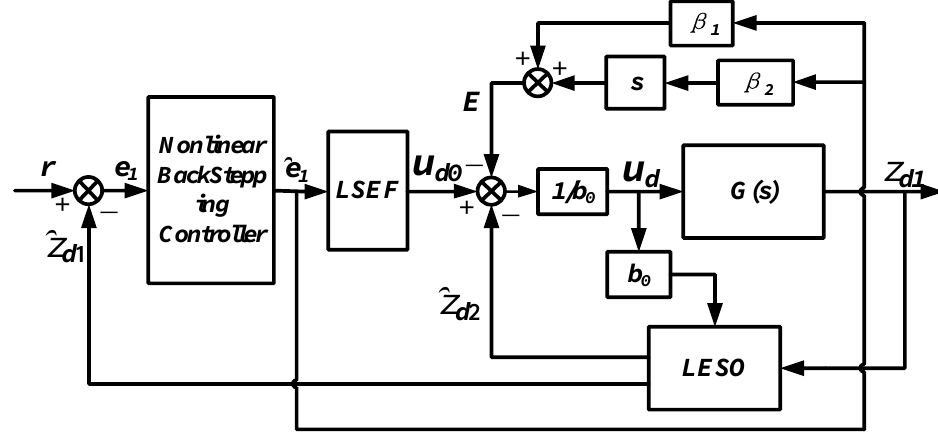
Figure 4. Tracking performance of backstepping controller.